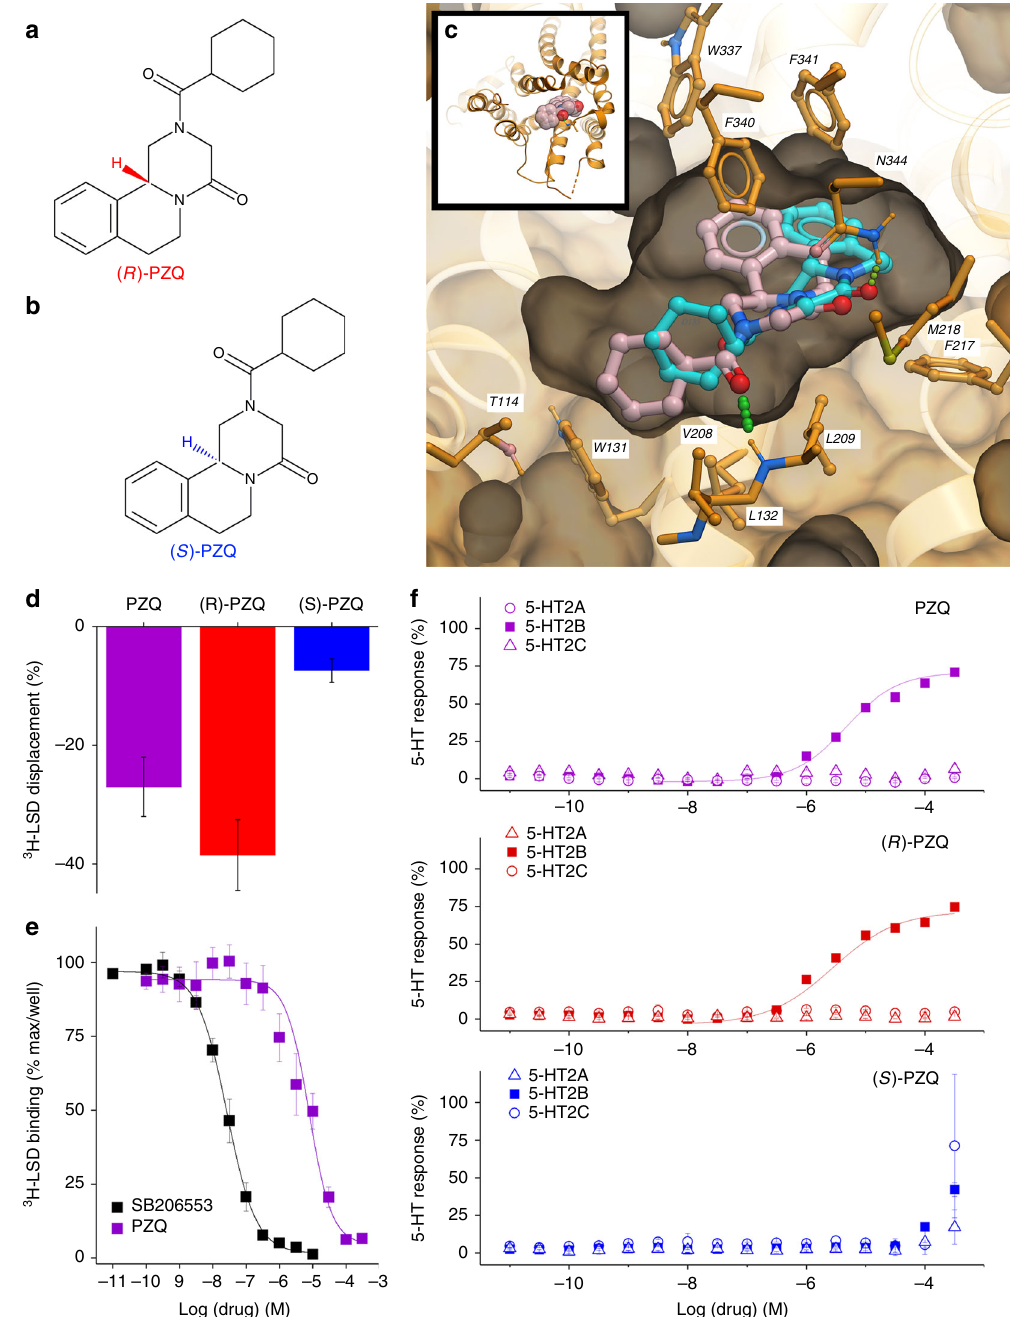
Fig. 1 Resolution of stereoselective (R)- PZQ interaction with human 5-HT 2B R. Structures of the PZQ enantiomers: active, a antischistocidal (R)- PZQ (top, red) and b (S)- PZQ (bottom, blue). c Docking poses of R-PZQ (light red) and S-PZQ (light blue) in the human 5HT 2B R. Both isomers of PZQ dock favorably within the orthosteric pocket of the 5HT 2B R crystal structure (Protein Databank Code: 5TVN). The R-isomer shows a better predicted binding score by 0.6 kcal/mole partially due to a more favorable hydrogen bond with the backbone NH group of L209. d Displacement of 3 H-LSD binding at human 5-HT 2B R by racemic PZQ (( ± )-PZQ 10 µ M, purple), (R)- PZQ (5 µ M, red) and (S)- PZQ (5 µ M, blue) in the PDSP primary screen ( n = 5 for all measurements). e Complete binding displacement curves for 3 H-LSD displacement at human 5-HT 2B R for SB206553 (black) and ( ± )-PZQ (purple, n = 5 for both ligands). f Functional Assays. Ca 2+ fl ux assays showing responses from fl uo-4 loaded Flp-In T-REx cells stably expressing 5-HT 2A R, 5-HT 2B R, or 5-HT 2C R at indicated concentrations of ( ± )-PZQ (purple, top), (R)- PZQ (red, middle) and (S)- PZQ (blue, bottom; n = 3 for each concentration) in cells